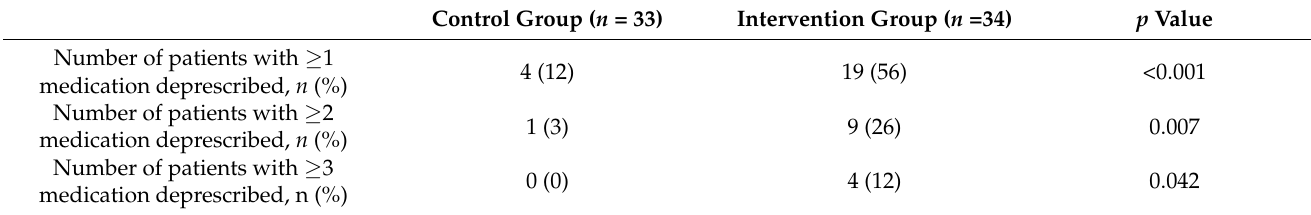
Table 2. Number of patients with sustained deprescribed medications from inclusion to 30 days post